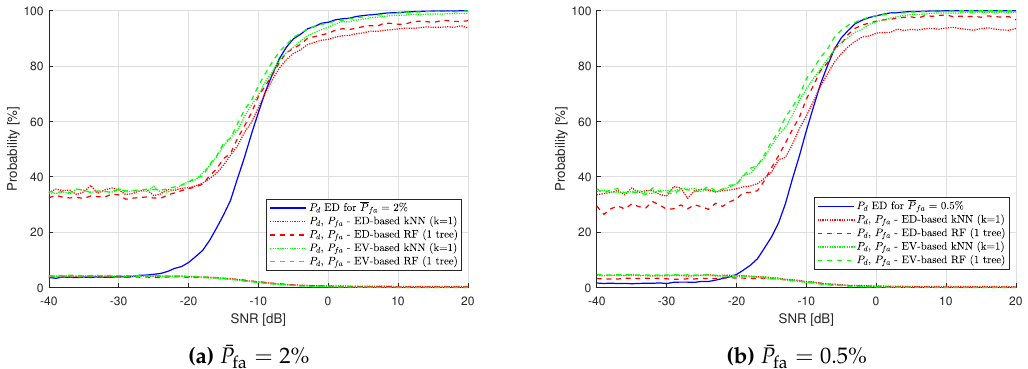
Figure 12. Probability of detection P d comparison of the Energy Detection-based and Energy Vector-based k-Nearest Neighbors and Random Forest methods for different assumed ¯ P fa .